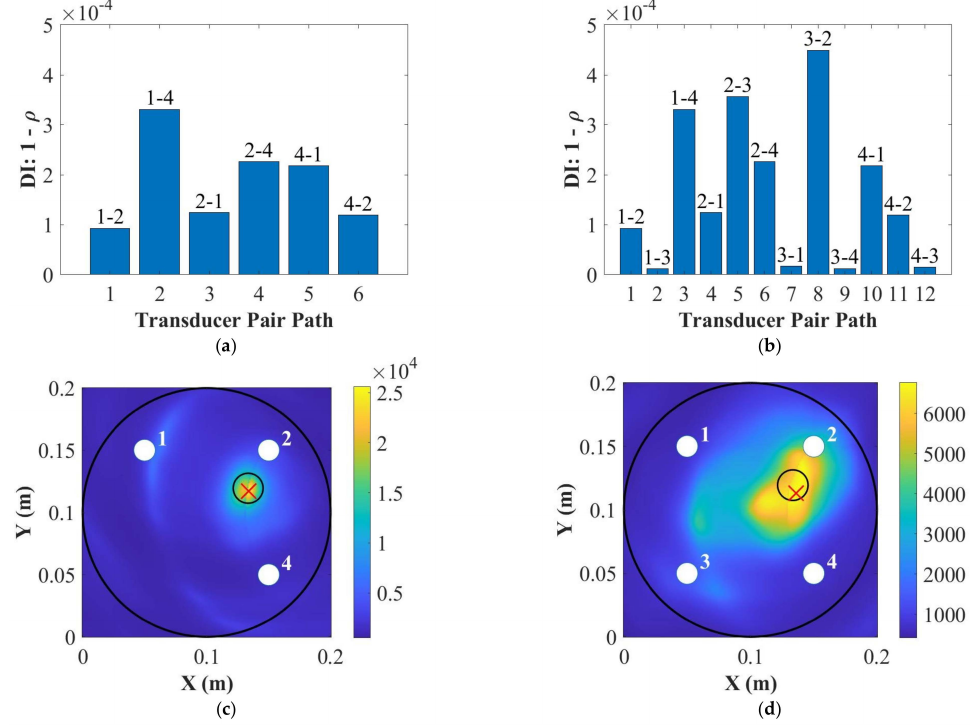
Figure 7. Detection of surface-mounted artificial damage on the surface of the repair patch using ( a ) three PZT transducers and ( b ) four PZT transducers, and localization using ( c ) three PZT